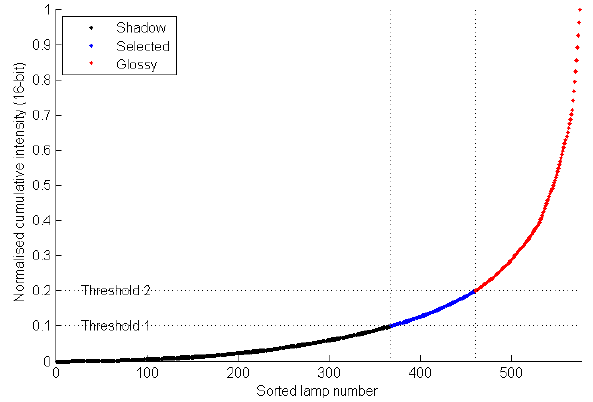
Figure 13. (left) specular normal vectors; (right) specular